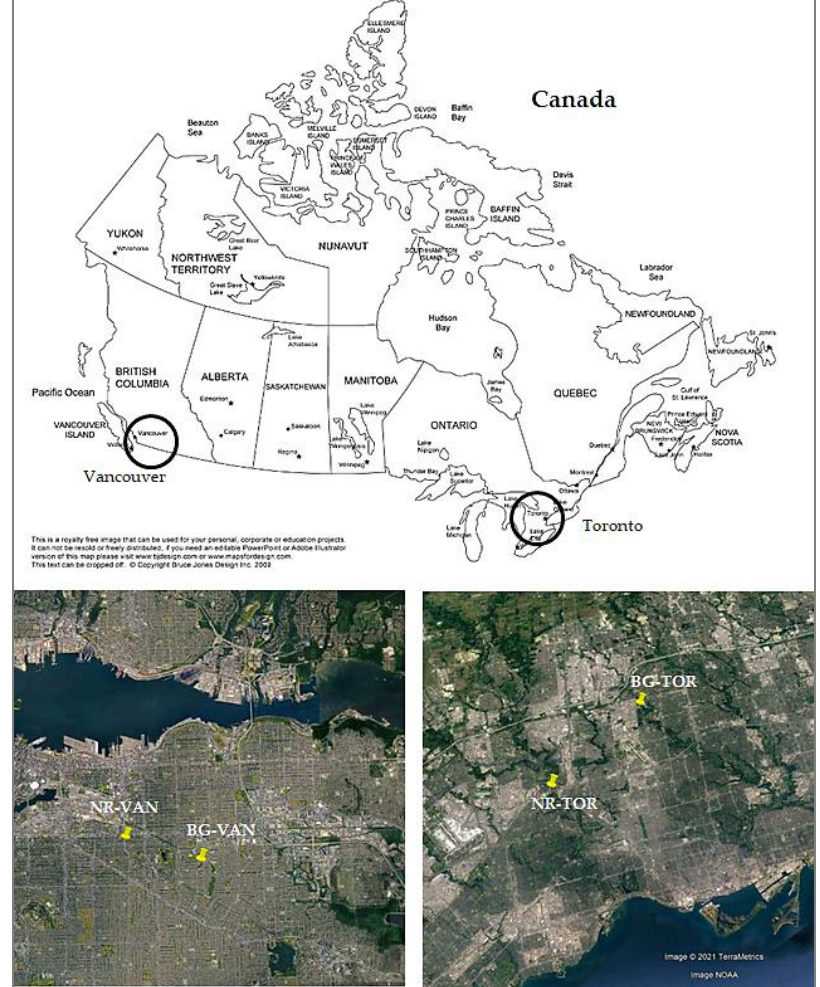
Figure 1. Map showing the sampling locations.